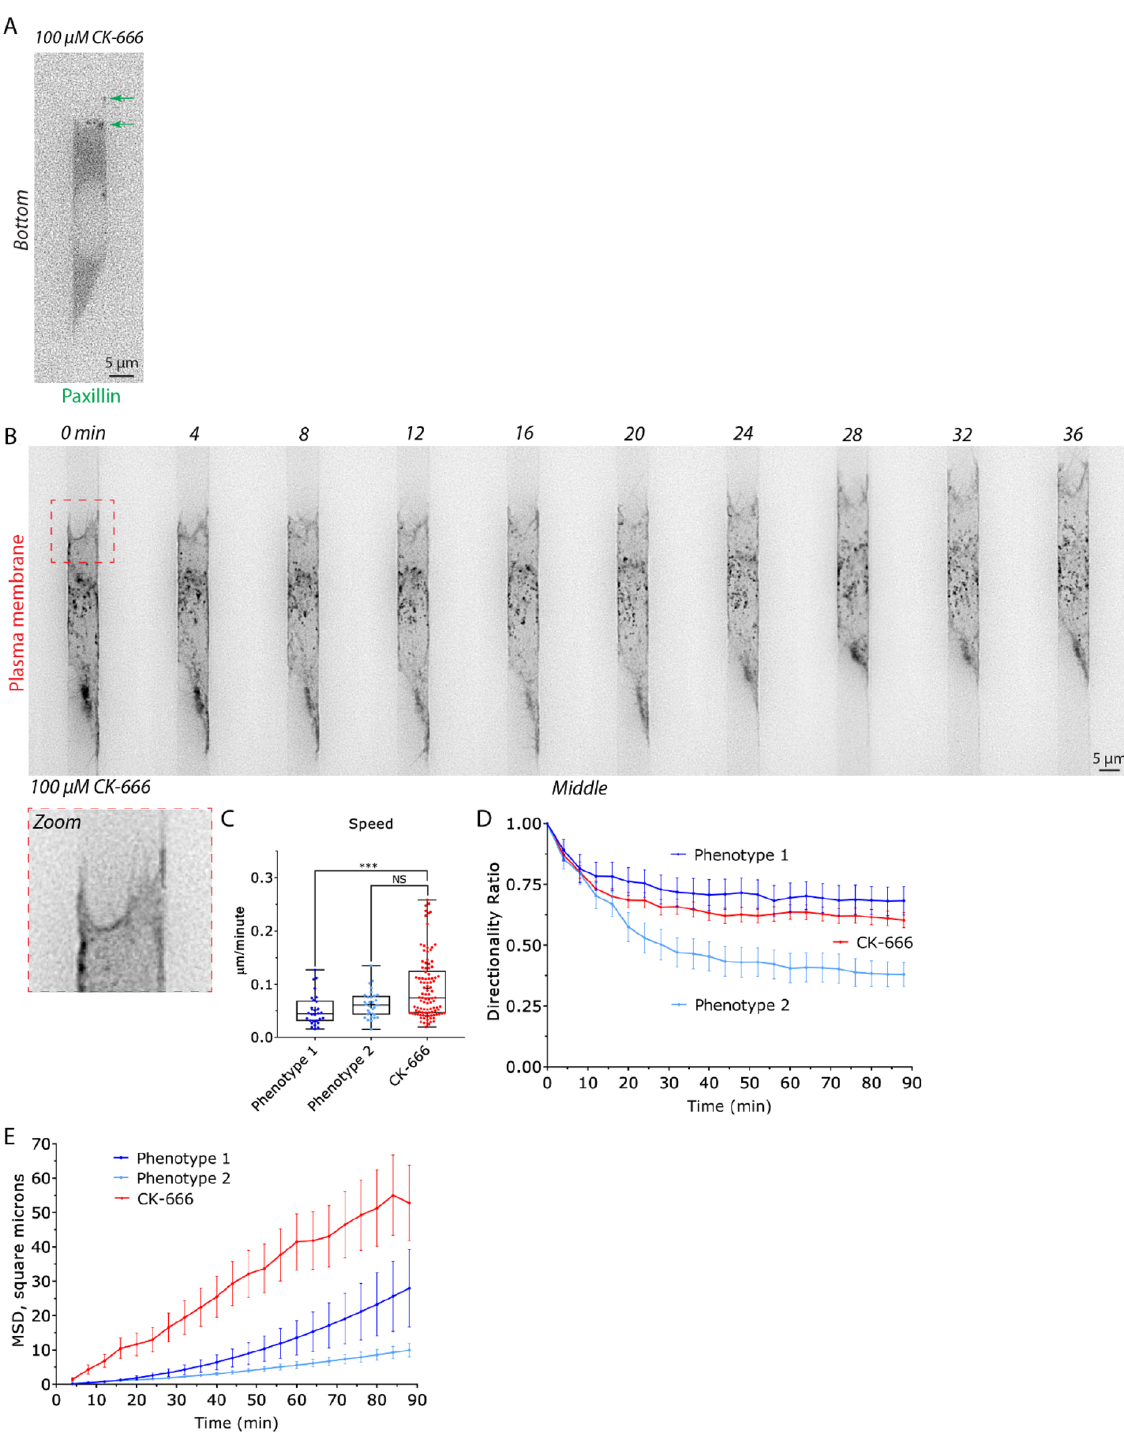
Figure 6. Upon down-regulating Arp2/3 activity, melanoma cells adopt a fast filopodial-based mode of migration. ( A ) A375-M2 cell treated with the Arp2/3 inhibitor, CK-666 (100 µM), within a fibronectin coated (10 µg/mL) microchannel with EGFP-paxillin to mark focal adhesions (green arrows). The bottom (ventral) focal plane is shown. ( B ) Montage of a melanoma A375-M2 cell treated with the Arp2/3 inhibitor, CK-666 (100 µM), within a fibronectin coated (10 µg/mL) microchannel. Cells were visualized using a far red membrane dye. Zoom shows several filopodia at the cell leading edge. ( C ) A comparison of instantaneous speeds for phenotype 1 (N = 28), 2 (N = 31), and CK-666 (N = 102) treated cells. Statistical significance was determined by a Dunn’s multiple-comparison test post-hoc. ( D ) A comparison of directionality ratio over time for phenotype 1 (N = 28), 2 (N = 31), and CK-666 (N = 102) treated cells. Error is SEM. ( E ) A comparison of Mean Square Displacement (MSD; square microns) over time for phenotype 1 (N = 28), 2 (N = 31), and CK-666 (N = 102) treated cells. All data are representative of at least three